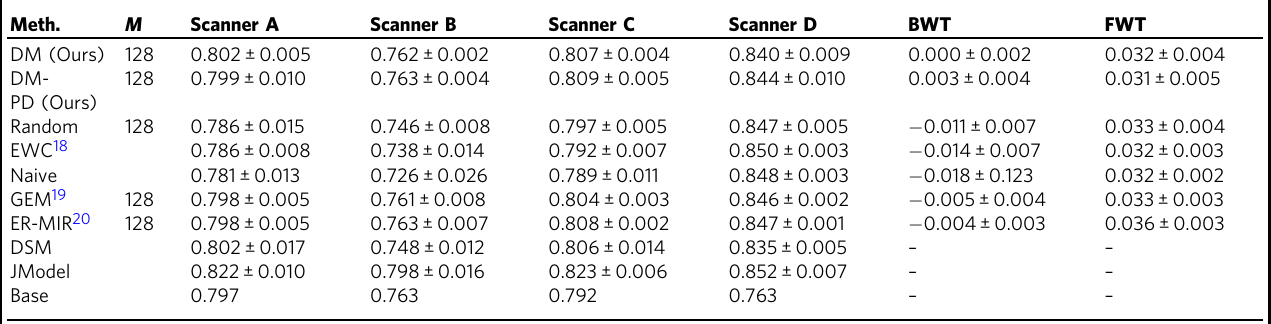
Table 2 Cardiac MR segmentation results after continual training measured as an average Dice score (DSC) over LV, RV and MYO segmentation computed on the test set.